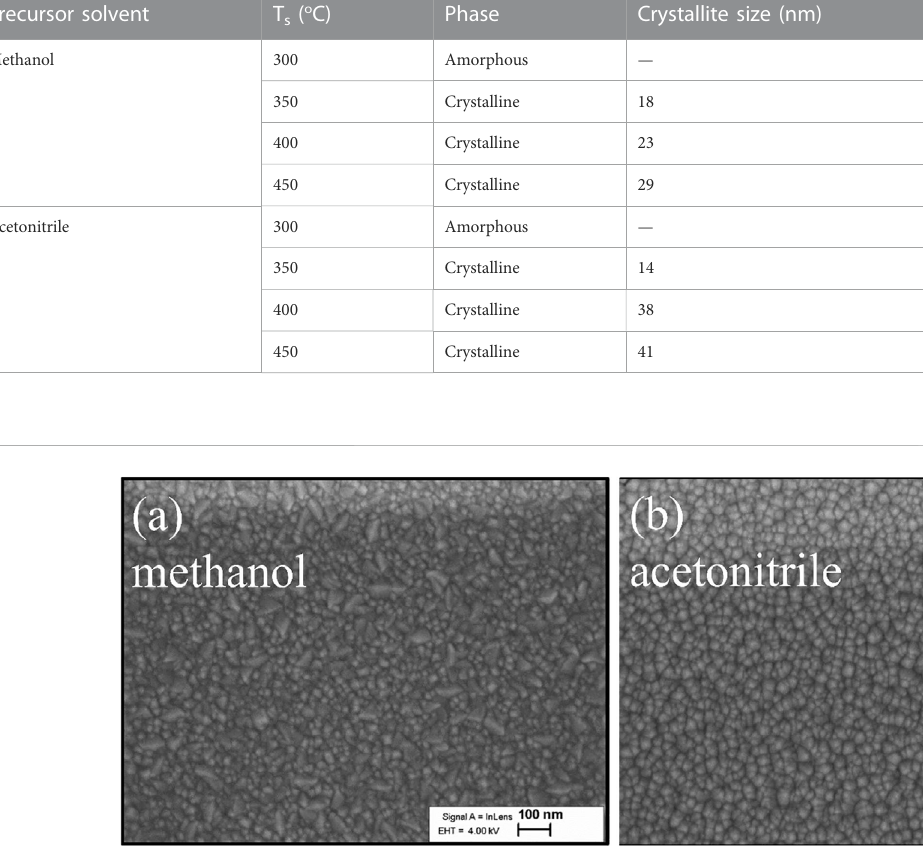
Top-down view of SEM images of the deposited NiO x thin fi lm obtained from (A) methanol, and (B) acetonitrile as precursor solvent at T s = 400 ° C.